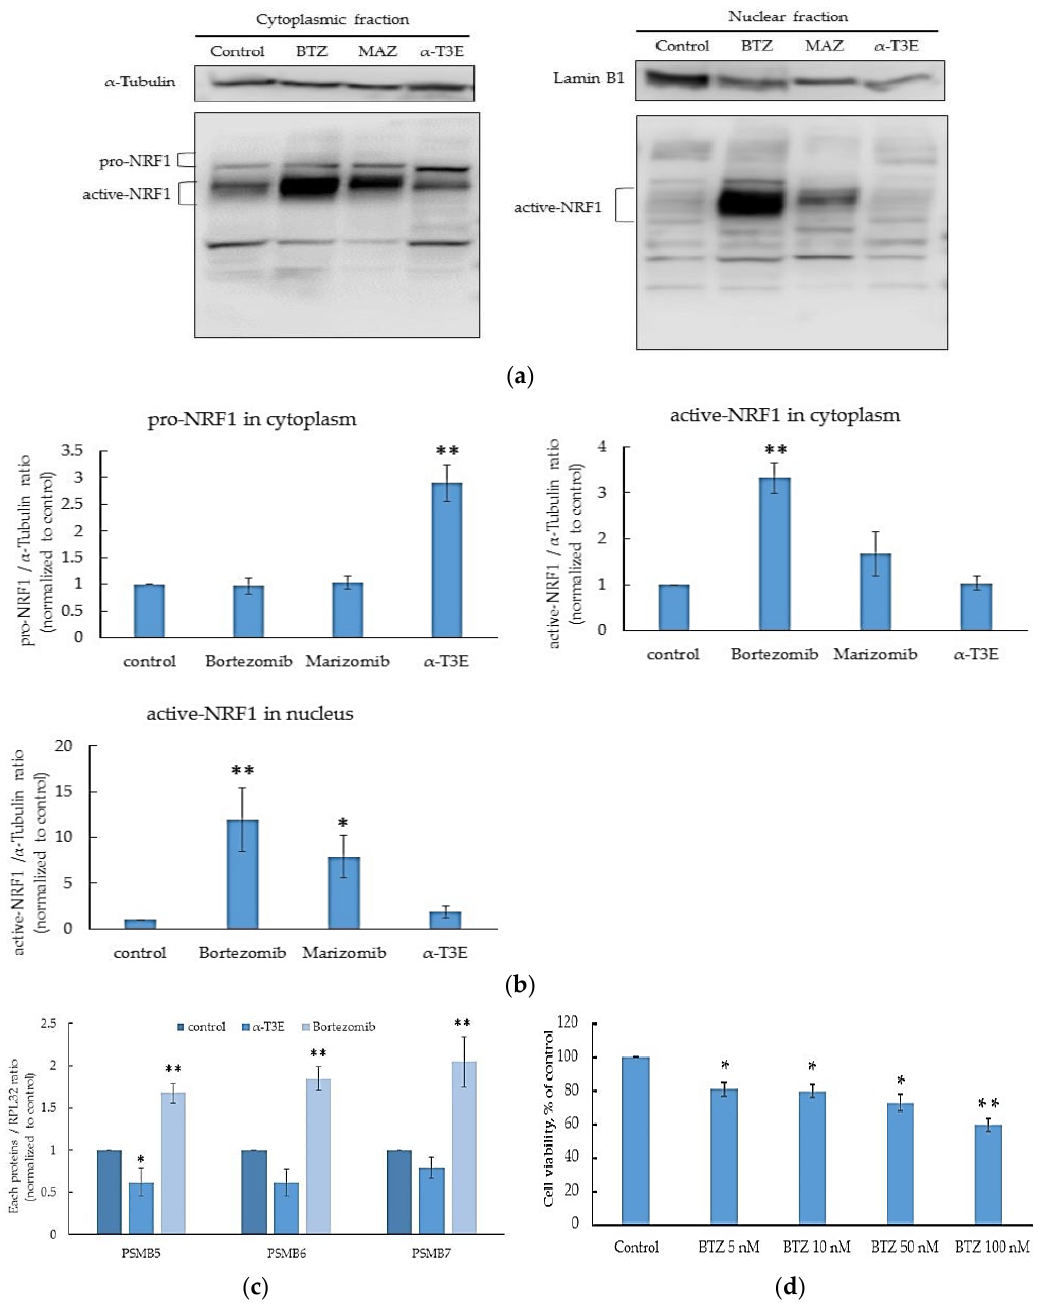
Figure 4. Inhibitory effects of α -T3E on NRF1 activation in H2452 cells. ( a ) Cells were treated with α -T3E (20 µM), bortezomib (50 nM), and marizomib (10 nM) for 12 h, and the protein levels of pro-NRF1 and active NRF1 in the cytoplasm and active NRF1 in the nucleus were assessed by immunoblotting. The α -Tubulin protein levels and lamin B1 protein levels served as the loading controls in the cytoplasm and nucleus, respectively. These results are representative of three independent experiments. ( b ) A densitometric analysis of pro-NRF1 and active NRF1 in the cytoplasm and active NRF1 in the nucleus was performed as described in Section 4.7. The data are means ± SD, n = 3. * p < 0.05, ** p < 0.01 vs. the control. ( c ) Cells were treated with α -T3E (20 µM) and bortezomib (50 nM) for 12 h, and the mRNA levels of proteasome subunits were assessed by real-time quantitative PCR. The data are means ± SD, n = 3. * p < 0.05, ** p < 0.01 vs. the control. ( d ) Cells were treated with each concentration of bortezomib for 24 h, and cell viability was assessed by WST-8. The data are means ± SD, n = 5. * p < 0.05, ** p < 0.01 vs. the control.